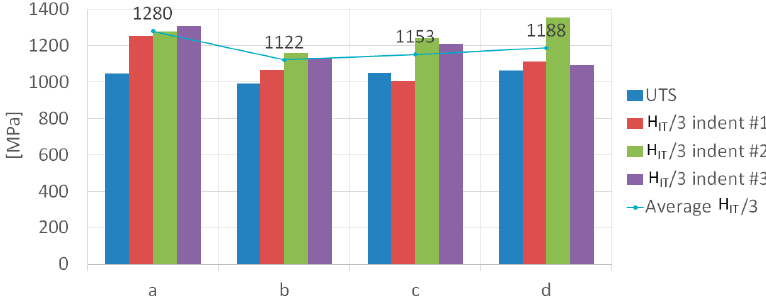
Figure 16. Comparison between UTS and representative stress from Tabor law ( H IT /3) for three